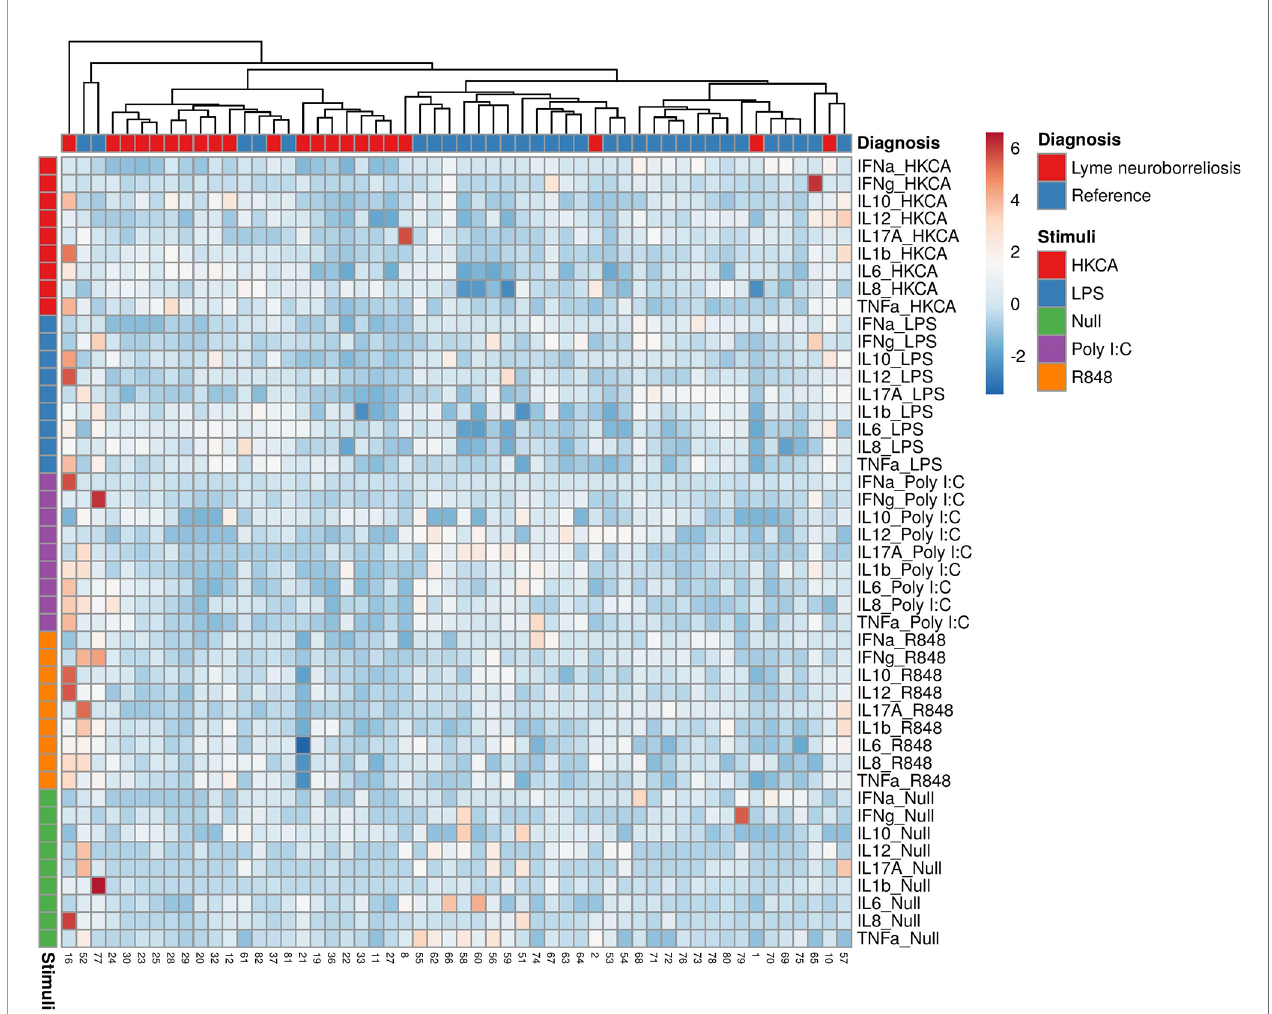
FIGURE 1 | Heatmap of individual cytokine response signatures in patients with LNB (red) and references (blue). The stimulations are divided and shown horizontally, HKCA (red), LPS (blue), PolyI:C (purple), R848 (orange) and Null (green). The individual response is shown in vertical columns and every square represent the cytokine response for the given stimulation. Column (diagnosis) dendrograms were drawn based on hierarchical clustering analysis using the complete agglomeration method on Euclidian distance matrices and Ward